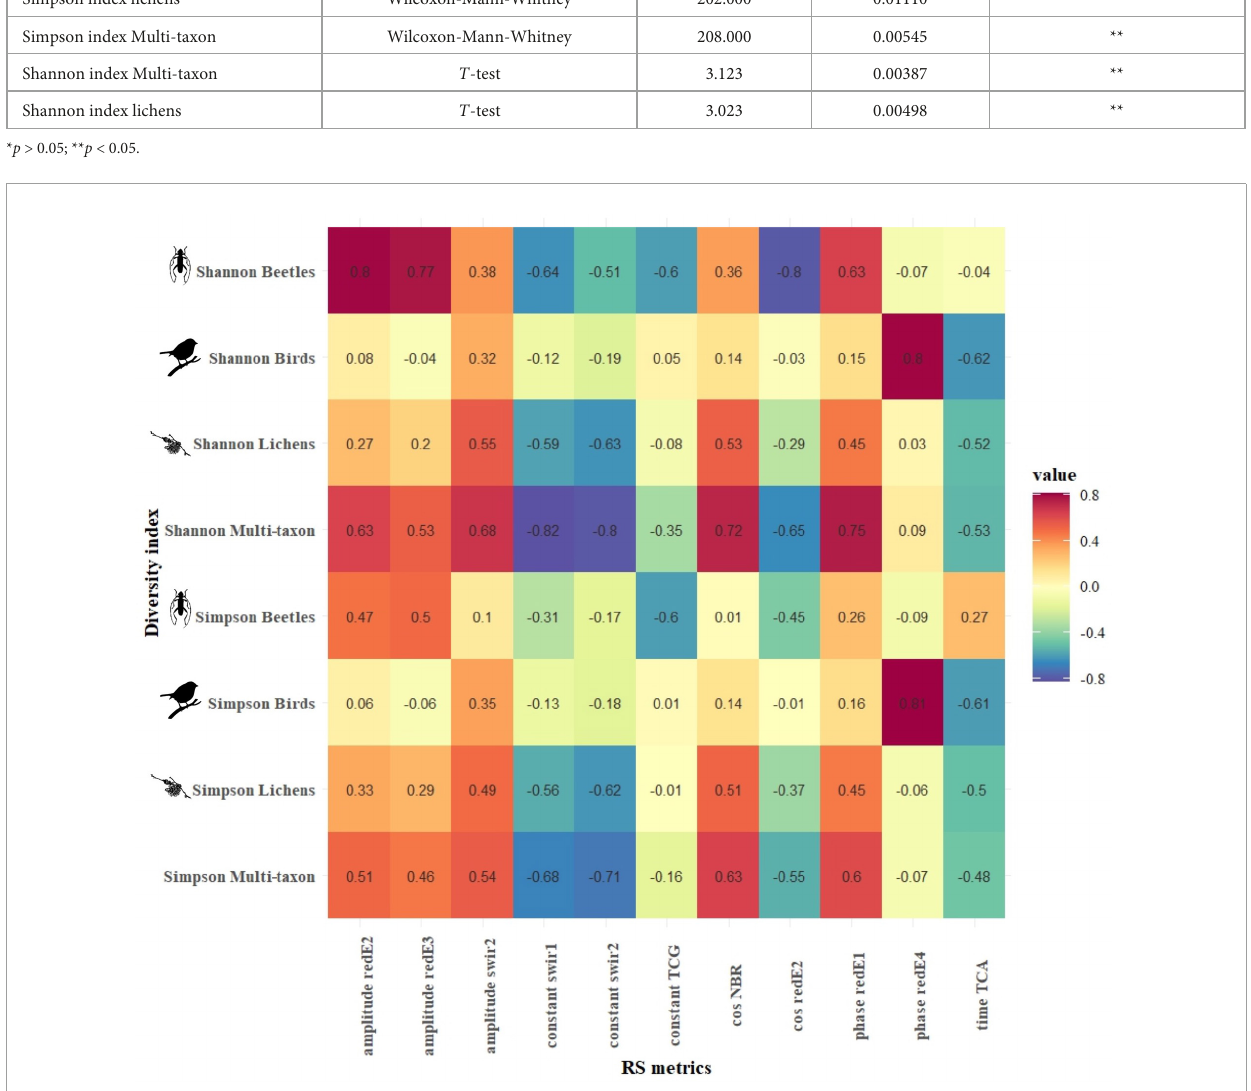
FIGURE4 CVDA: Pearson’s product-moment correlation (r) between biodiversity indices of each taxon (y-axis) and the best Sentinel-2-derived temporal metrics (x-axis). The color in each cell represents the correlation value between the corresponding variables in the two axes.